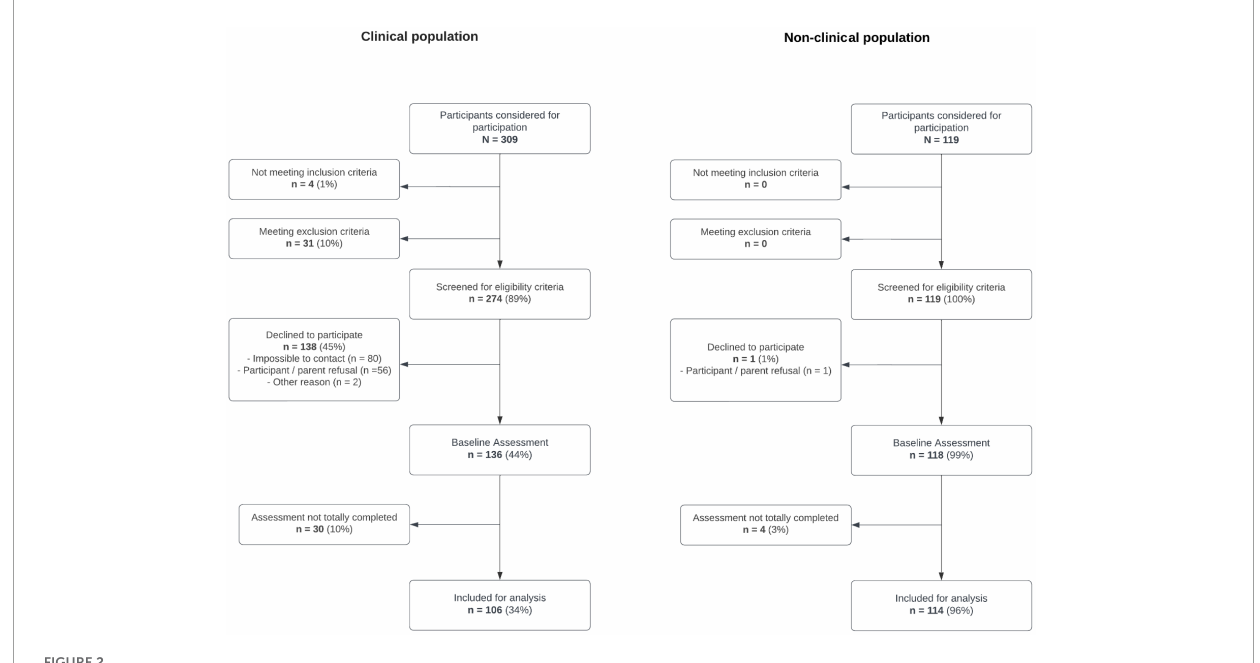
FIGURE2 Transition_psy study recruitment